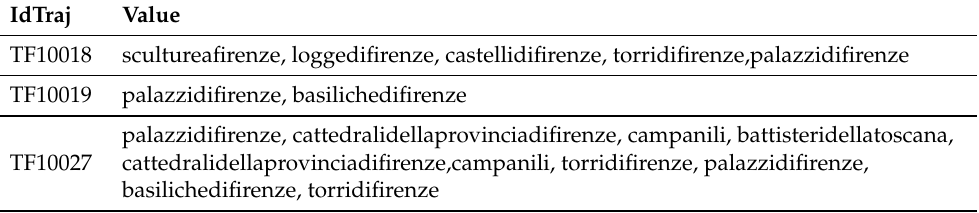
Table 14. Example of category trajectory.